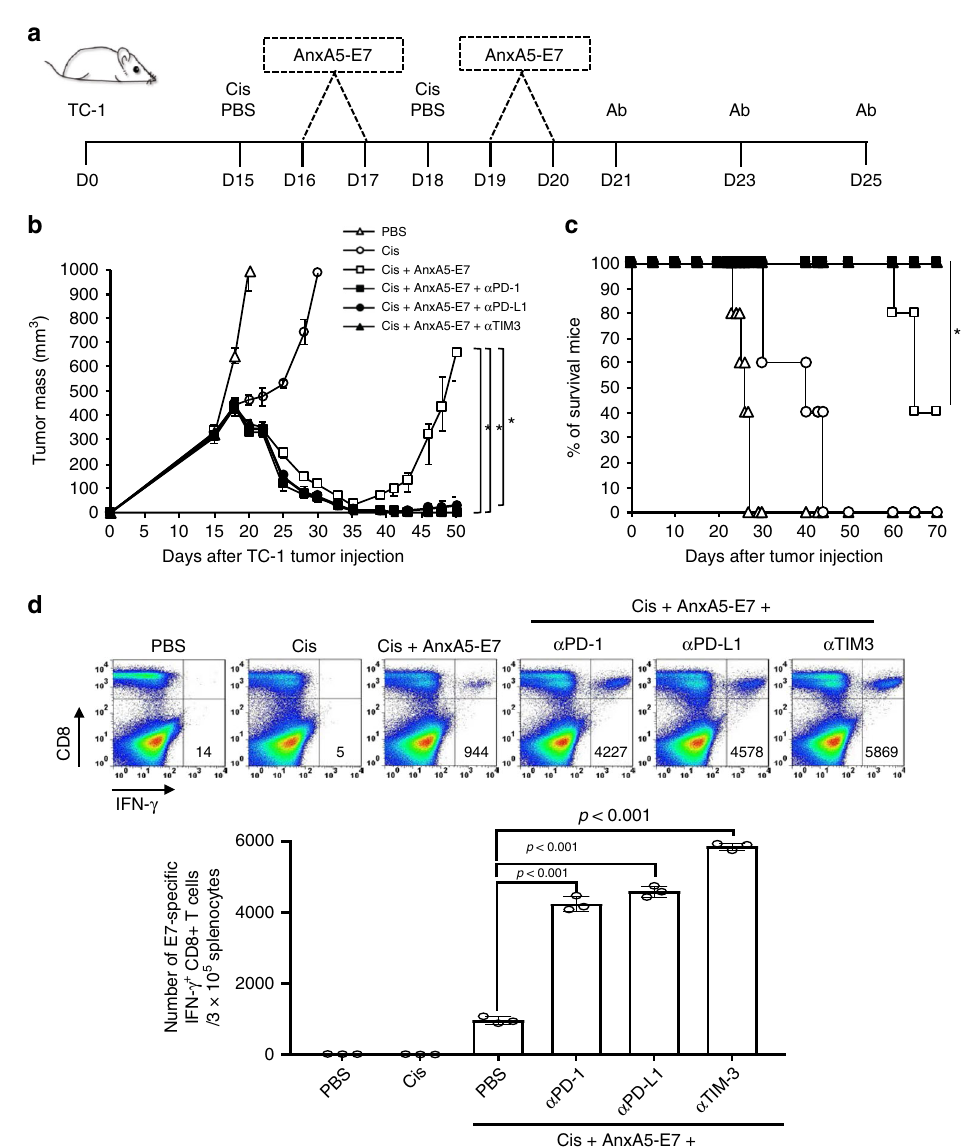
Fig. 7 Synergy of Annexin A5-E7 fusion protein and immune checkpoint inhibitors. C57BL/6 mice were injected with 2 × 10 5 TC-1 cells/mouse subcutaneously on day 0. Mice were then treated intraperitoneally with 5 mg/kg Cisplatin on days 15 and 18, intravenously with 200jig/mice of AnxA5-E7 proteins on days 16, 17, 19, and 20, and/or intraperitoneally with 200jig/mice of anti-PD-1, anti-PD-L1, or anti-TIM-3 antibodies on days 21, 23, and 25. The treatment groups are as follows: opened triangle - PBS only; opened circle - cisplatin only; opened square - cisplatin and Annexin 5A-E7; closed square – cisplatin, Annexin 5A-E7, and anti-PD-1; closed circle – cisplatin, Annexin 5A-E7, and anti-PD-L1; closed triangle - cisplatin, Annexin A5-E7, and anti-TIM3. a Schematic diagram. b Line graph depicting TC-1 tumor growth in different treatment groups over time ( n = 10). P -values were determined by one-way ANOVA and Turkey ’ s test. c Kaplan – Meier survival analysis of TC-1 tumor-bearing mice in different treatment groups ( n = 10), and the overall P -value was calculated by the log-rank test. d One week after the last AnxA5-E7 vaccination, spleens of TC-1 tumor-bearing mice in different treatment groups were harvested and analyzed for CD8 + IFN- γ + T cells by fl ow cytometry analysis. Figure showing representative fl ow cytometry analysis and bar graph depicting the abundance of CD8 + IFN- γ + T cells in splenocytes of TC-1 tumor-bearing mice in different treatment groups ( n = 3). P -values were analyzed by Student ’ s t test. The error bars indicate mean ± SD. The results are representative of one of three independent experiments. Source data are provided as a Source Data fi In vitro endotoxin-free Annexin A5 experiment . Recombinant AnxA5 protein experiments were evaluated by analysis of variance (one-way ANOVA) and the Tukey – Kramer multiple comparison test. Comparisons between individual data (20jig/ml) was boiled 1 h or incubated with proteinase K (100jig/ml) (promega) at points were made using Student ’ s t tests. Survival distributions for mice in different 40°C for three hours or polymyxin B (10jig/ml) (sigma) at room temperature for groups were compared through Kaplan – Meier survival curves, and by use of the ten minutes and boiled to eliminate proteinase K effect. Dendritic cells were treated log-rank tests. All P values < 0.05 were considered signi fi cant. Of note, * , ** and with prepared AnxA5 protein and LPS (100ng/ml). Cells and supernatants were *** indicate P values less than 0.05, 0.01, and 0.001, respectively; N.S., not collected and measured with ELISA (TNF- α and IL-6) respectively. signi fi cant. Statistical analysis . All data are expressed as means ± standard deviation (S.D.) Reporting summary . Further information on research design is available in and are representative of at least three separate experiments. Results for intracel- the Nature Research Reporting Summary linked to this article. lular cytokine staining with fl ow cytometry analysis and tumor treatment